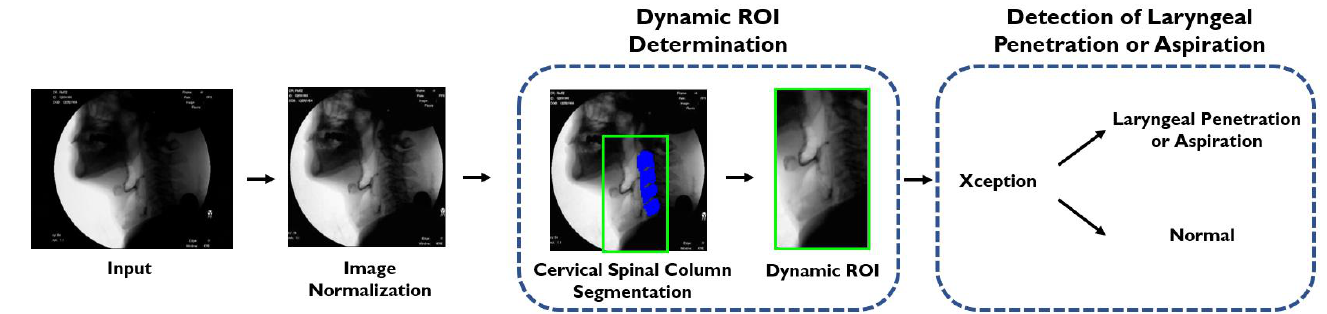
Figure 1. The same deep learning model we proposed in our previous study [20] is used in this study. After normalization of the input images, a dynamic ROI is defined with reference to the cervical spinal column segmented by U-net. The presence of laryngeal penetration or aspiration in the ROI can be identified by the Xception module.